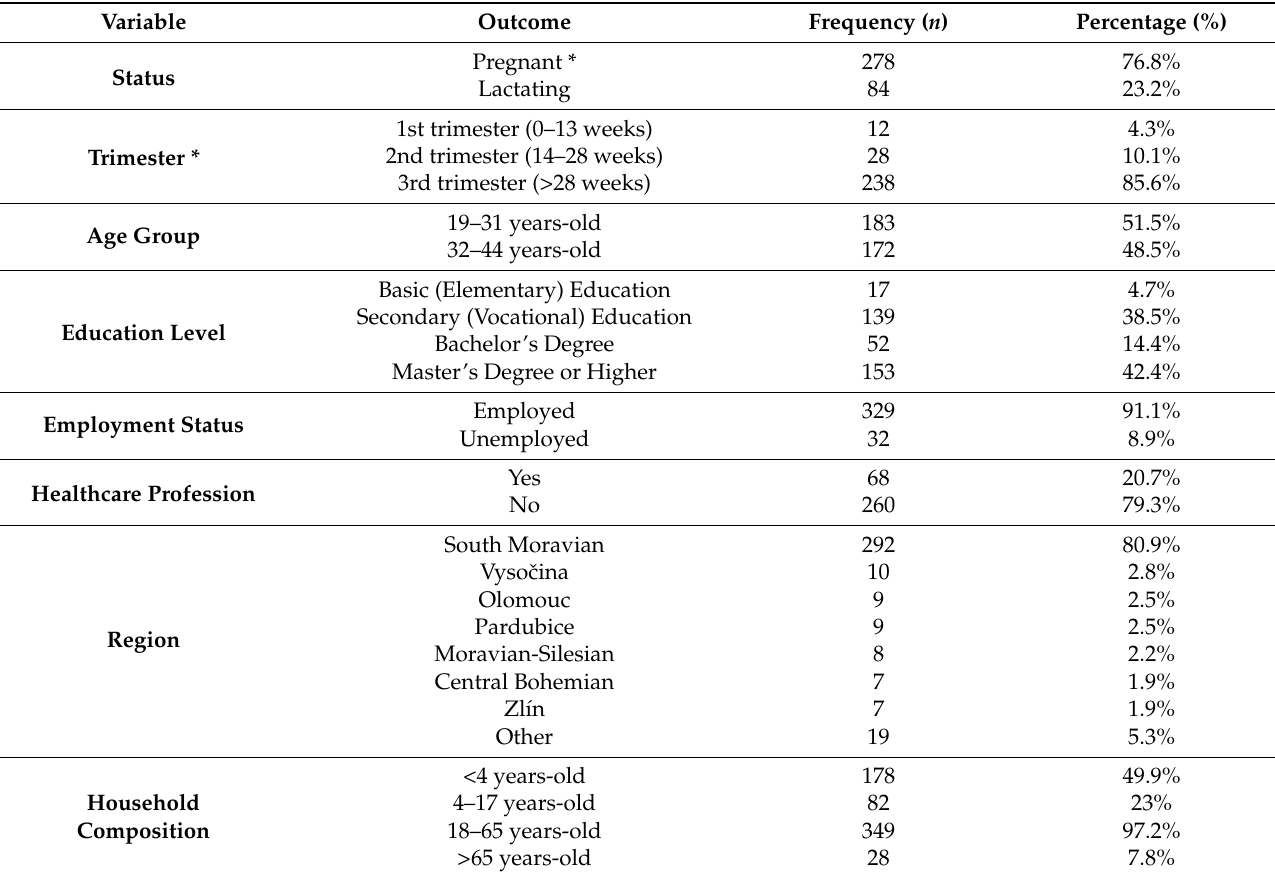
Table 1. Demographic characteristics of pregnant and lactating women (PLW), University Hospital Brno, August–October 2021 ( n = 362).